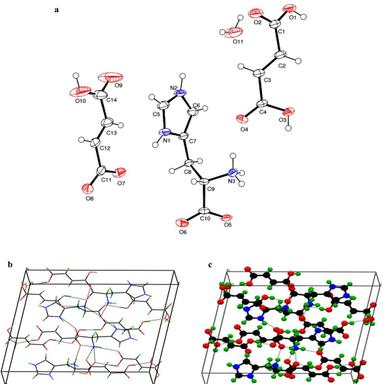
(a) The molecular structure of LHHFAM of displacement ellipsoids at 40% probability level. (b) The crystal packing fraction of the LHFFAM (The hydrogen bonds are exhibited by dashed lines). (c) The crystal packing of the LHFFAM showing the atom positions (The hydrogen bonds are exhibited by dashed lines).